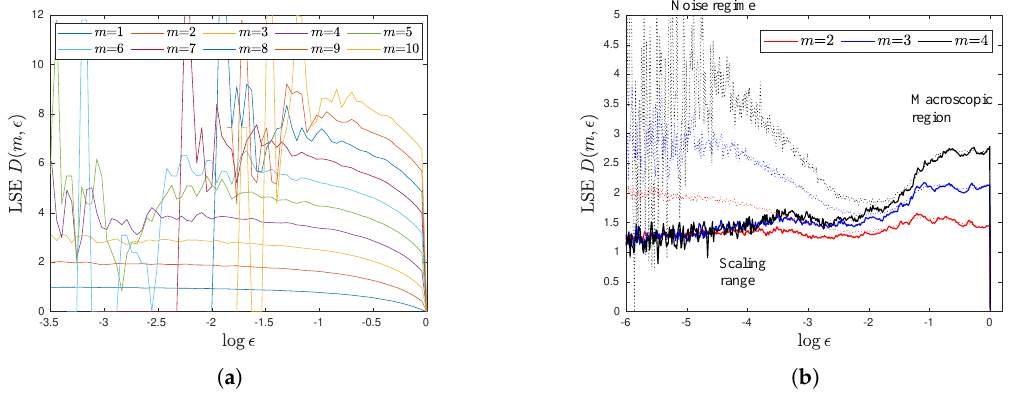
Figure 3. ( a ) Local scaling exponents (LSEs) for gaussian white noise with different embedding dimensions, m = 1, . . . ,10. ( b ) LSEs for Henon attractor of length 10,000 with and without 1.5% additive gaussian white noise; the embedding dimensions are set as m = 2, . . . ,4; the solid and dotted lines correspond to the noise free data and data with additive noise,